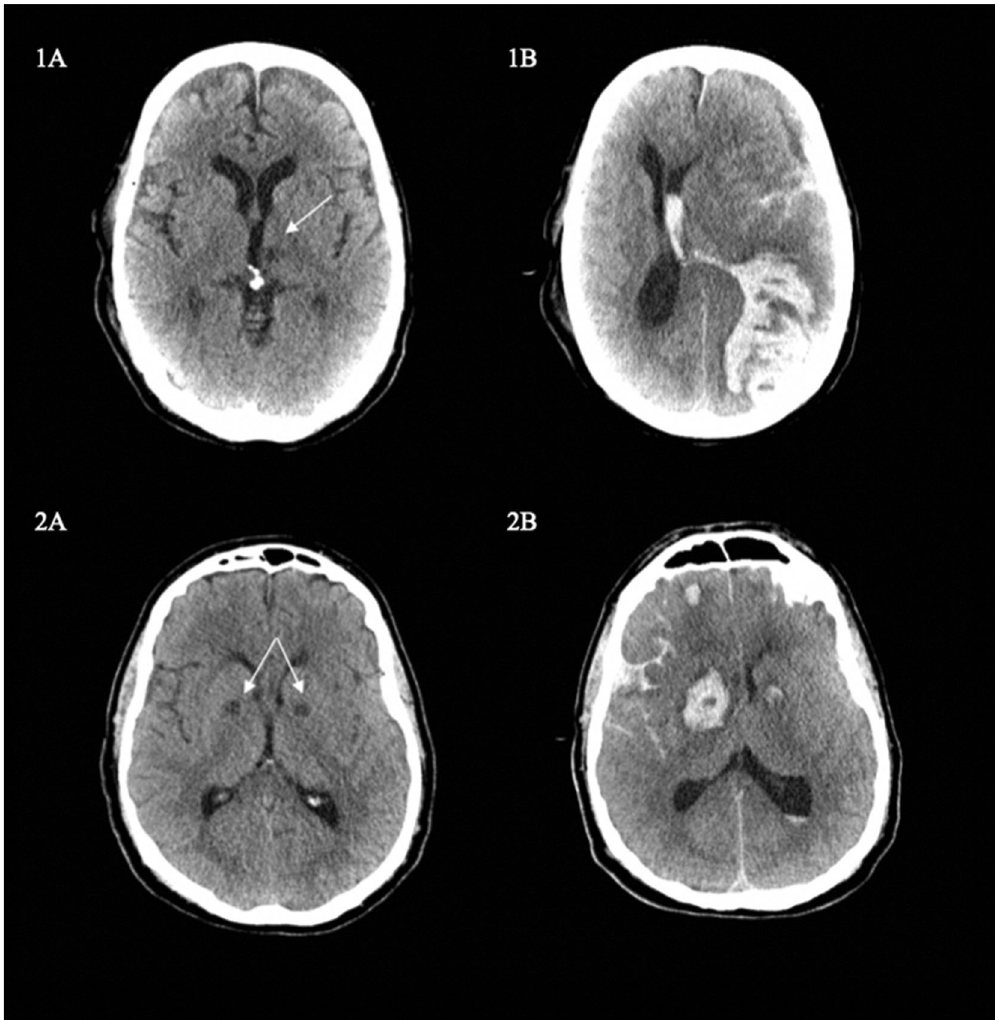
Figure 3. Two examples of hemorrhagic transformation following a brain infarction. Each arrow indicates a brain infarction that was diagnosed during ECMO treatment. Patient 1 had a radiologically verified brain infarction ( 1A ) and developed neurological symptoms the next day following massive bleeding and herniation ( 1B ). Patient 2 developed a symptomatic intracranial hemorrhage ( 2B ) 3 days following bilateral brain infarction in the basal ganglia ( 2A ).